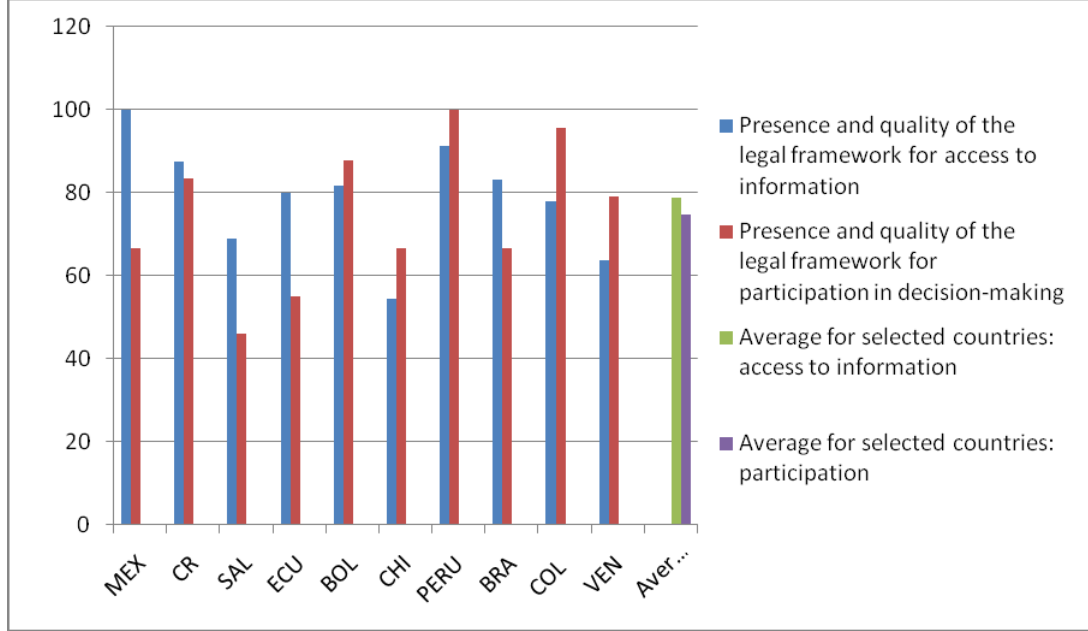
Figure 2 . Presence and quality of legal frameworks for participation and access to information in Chile, Colombia, Dominican Republic, Ecuador, Guatemala, Honduras, Mexico, Nicaragua, Panama, Peru and Uruguay (Data from